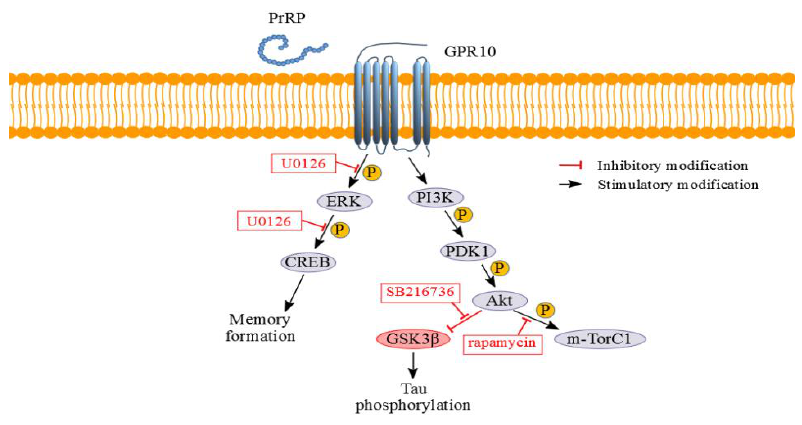
Figure 9. Schematic view of PrRP signaling pathways; P–phosphorylation.